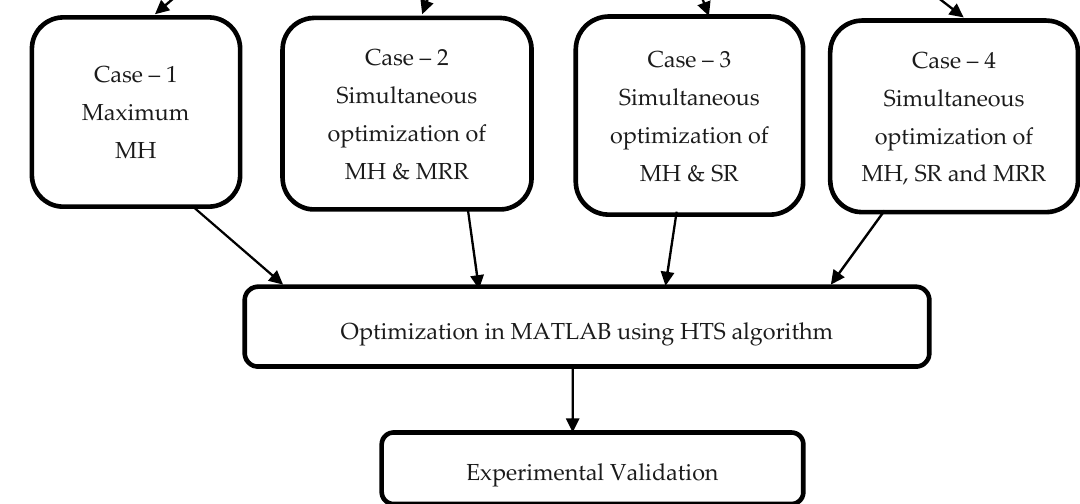
Figure 2. Proposed optimization route.